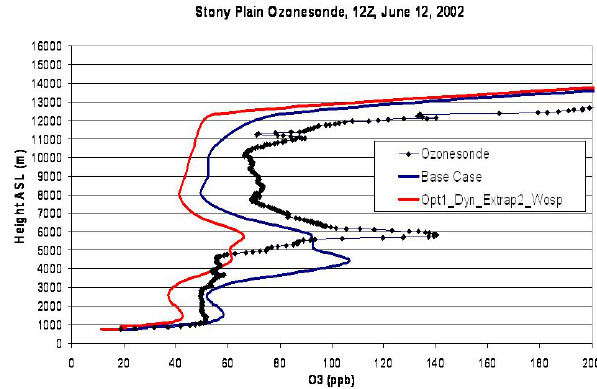
Fig. 14. Profile of ozone at Stony Plain, 12:00Z, 12 June